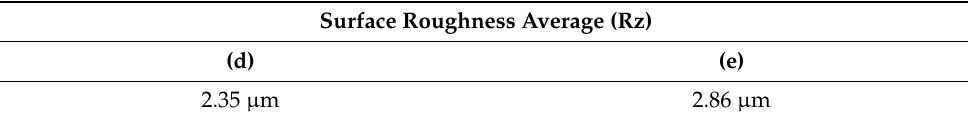
Table 6. Surface roughness Average (Rz) cases (d) and (e).